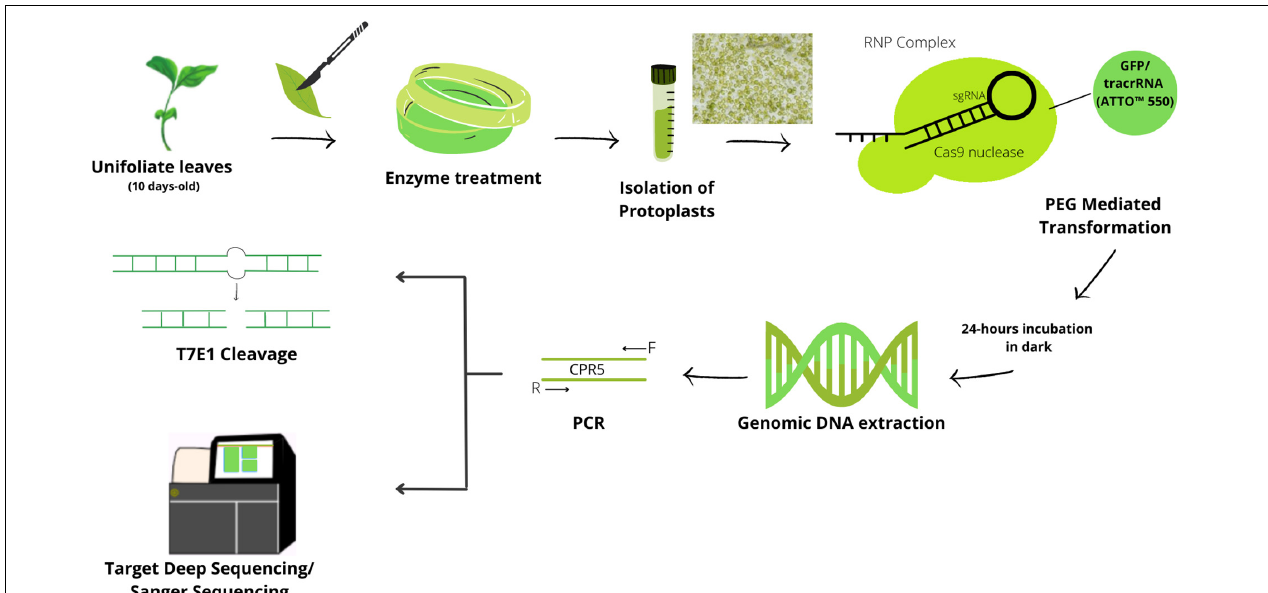
FIGURE 1 | Schematic protocol for CRISPR/Cas9-mediated DNA-free/transient genome editing in the soybean. The protoplasts were isolated from young seedlings of unifoliate leaf strips with enzyme solution. Isolated protoplasts were transformed with preassembled CRISPR-RNP complexes via the PEG-mediated method. The transformed protoplasts were subjected to either genomic DNA extraction or fluorescence-activated cell sorting (FACS) of Cas9-GFP expressing protoplasts for an enrichment followed by DNA extraction or to cultivation. Target sites are amplified by PCR followed by T7E1 validation of mutation and high-throughput sequencing for estimation of mutation efficiency.